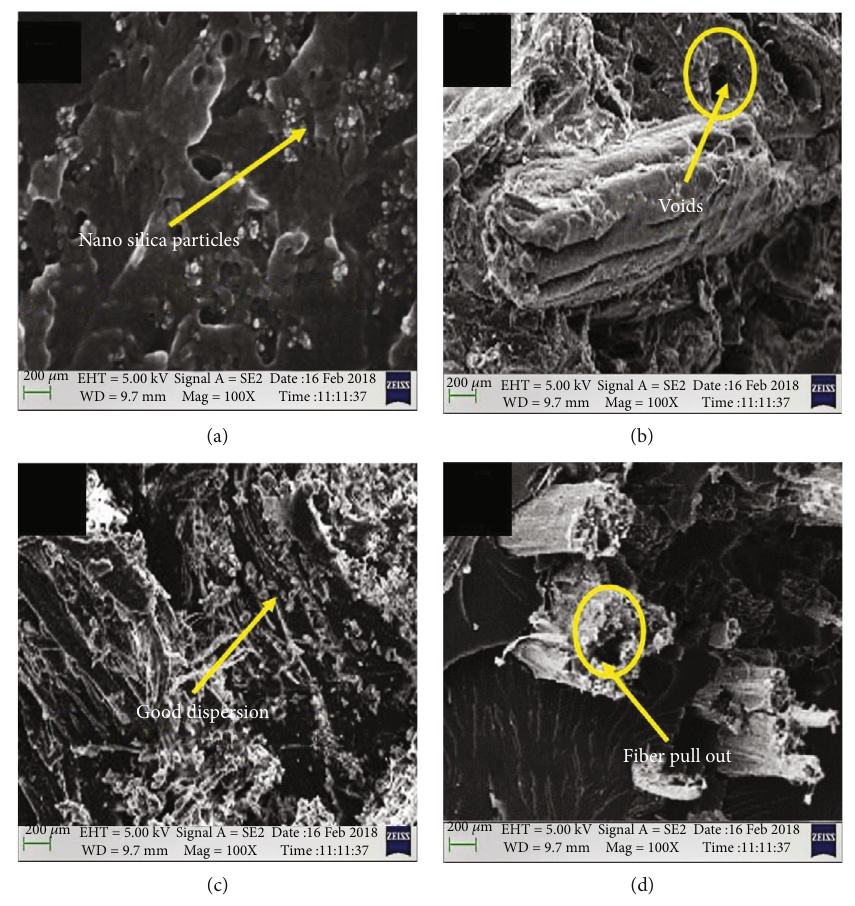
Figure 9: (a) – (d) Microstructural images of bio-based